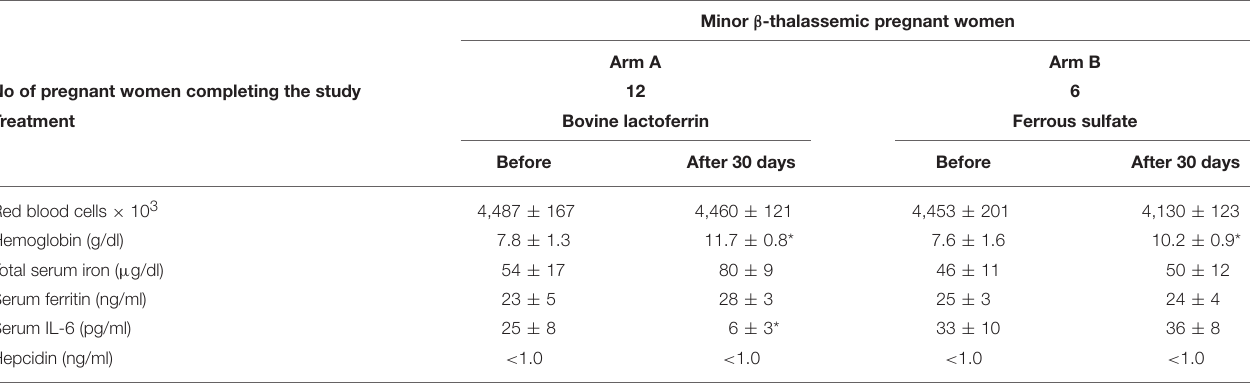
TABLE 4 | Hematological parameters, serum IL-6 and hepcidin mean values ± SD of anemic minor β -thalassemic pregnant women treated with bovine lactoferrin (Arm A) or ferrous sulfate (Arm B), before and after 30 days of treatment.